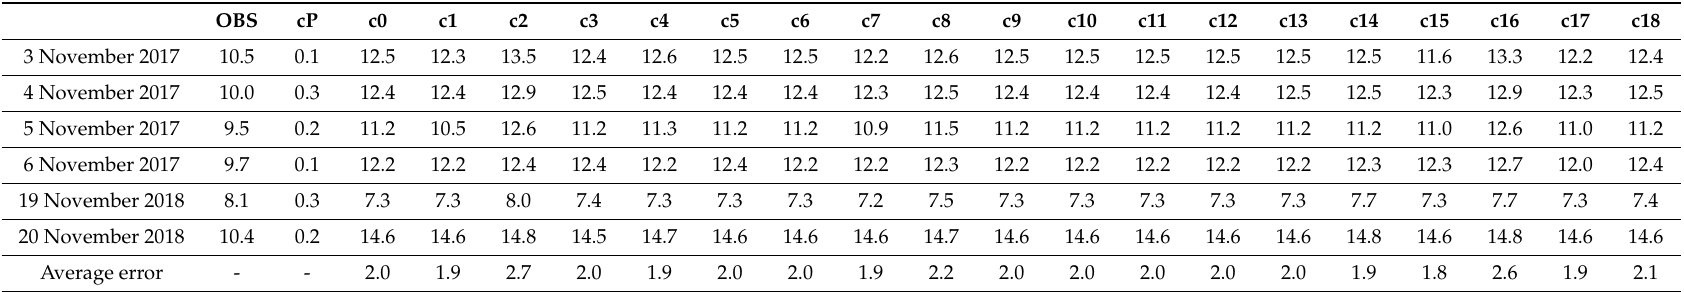
Table 5. Daily minimum T2m values ( ◦ C) at the CIRA site for the days considered, for observational and model data (all configurations). Average cumulative errors with respect to observations. Maximum deviation (cP) from the reference simulation with the initial condition ensemble.